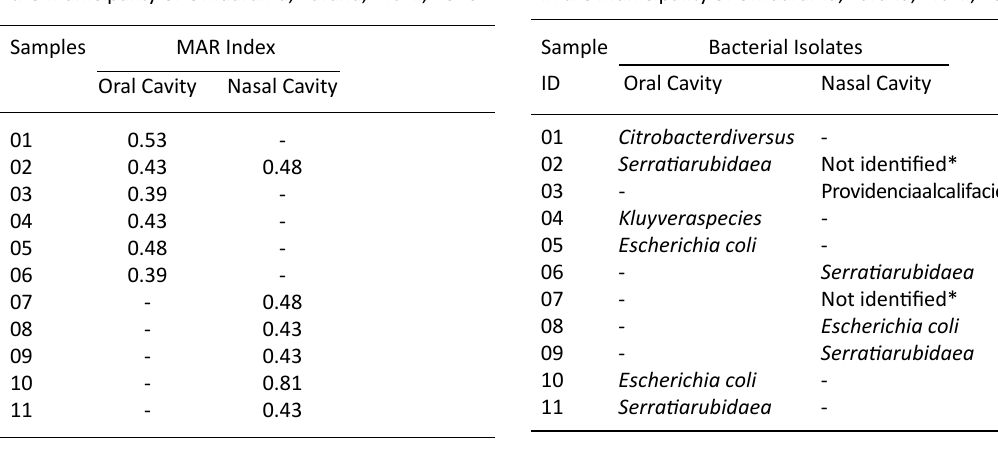
Legend: *No microbes from the Enterobacteriaceae family were identified. ESBL = extended-spectrum b